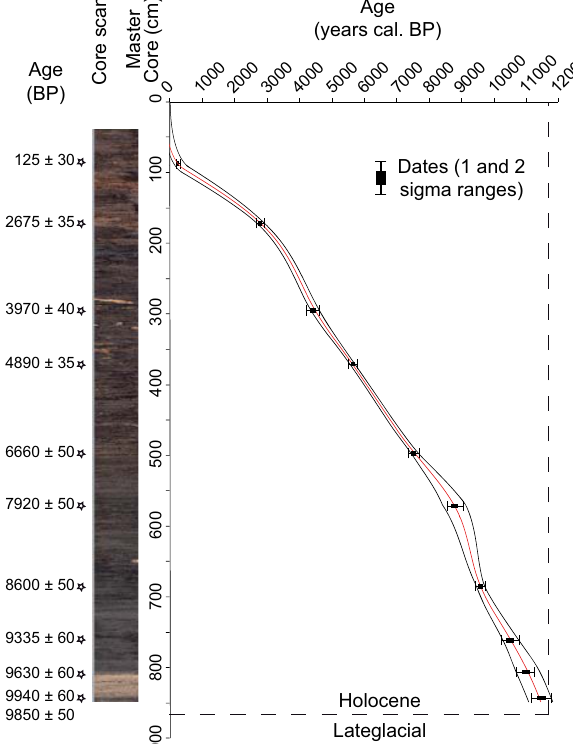
Fig. 5. Lithology and age-depth model of mastercore based on ra- diocarbon calibrated ages (AMS, see Table